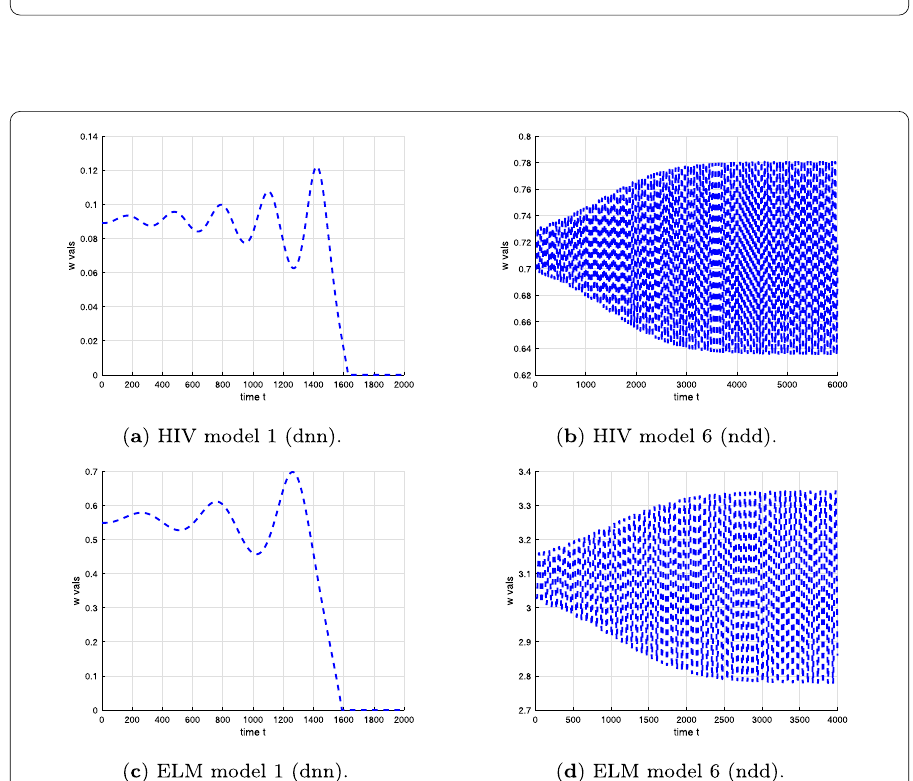
Figure 6 Solutions of HIV and ELM difference equations versions 1 and 6 for time delay greater than critical delay ( τ > τ c ) at m = 22 (see Tables 11 and